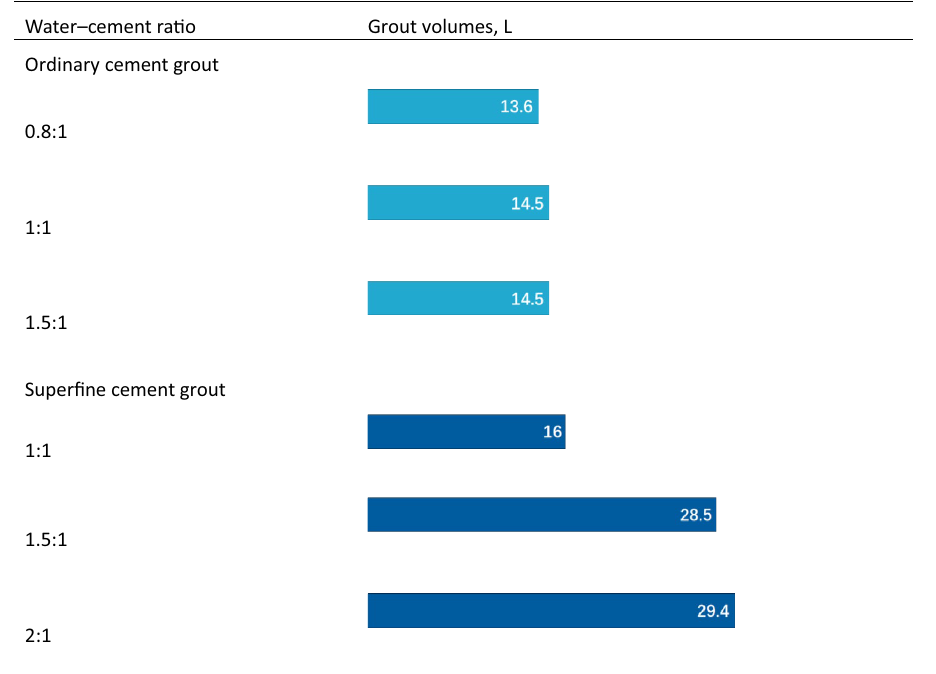
Table 4. Grout volumes of grouts with varying water–cement